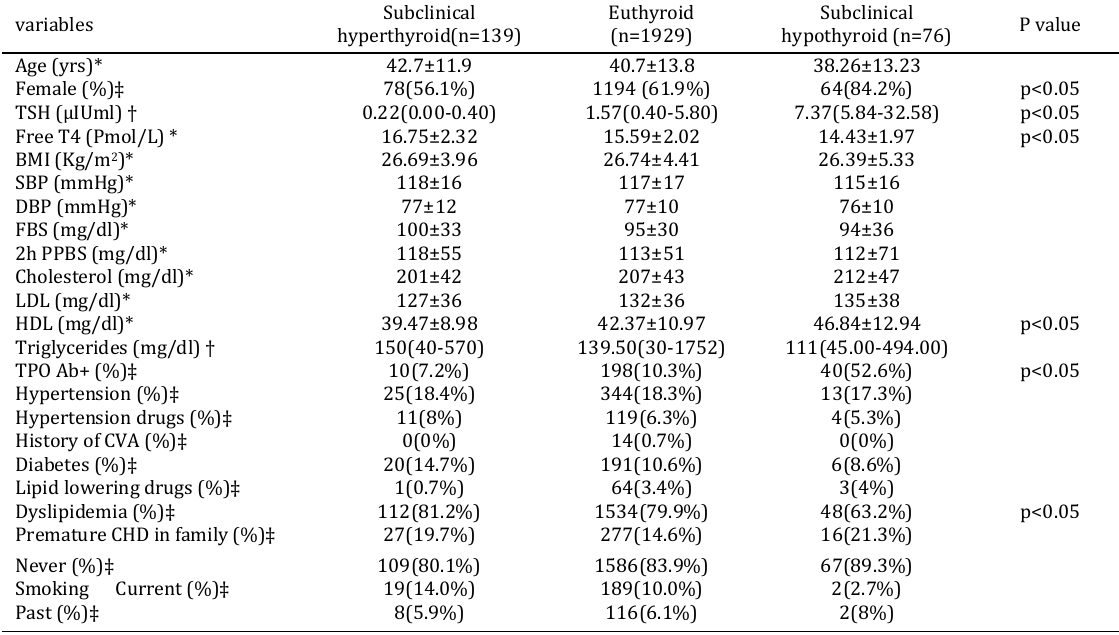
Table 1. Baseline characteristics of 3 groups at beginning of the